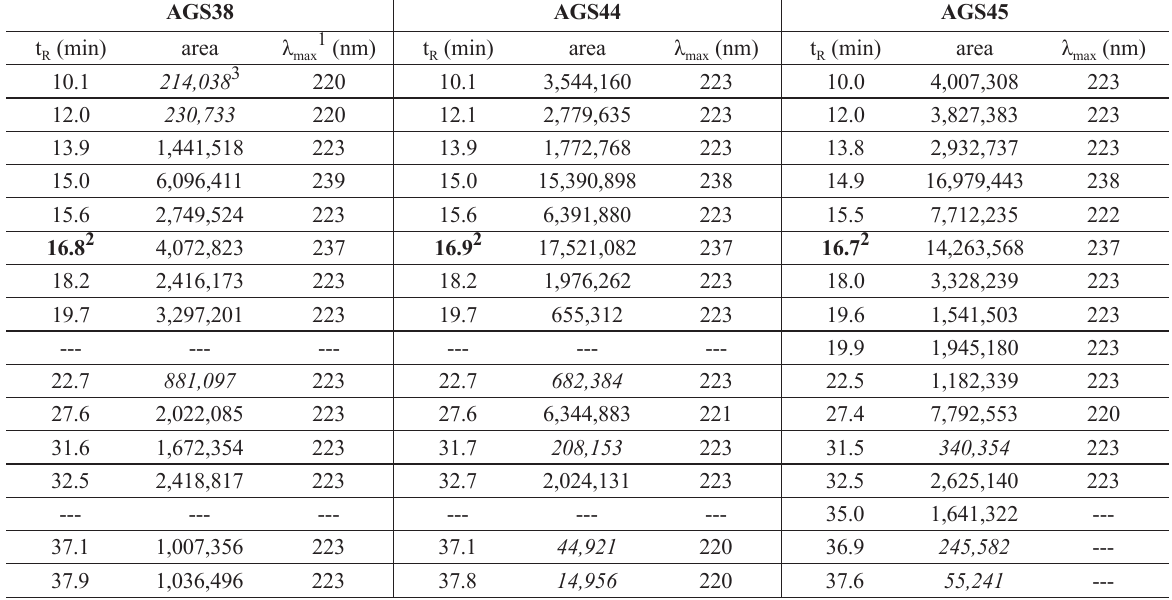
Data from HPLC-DAD analyses of specimens AGS38, AGS44 and AGS45. Retention time, area and λ of selected peaks (t > 10 min; area > 10 6 in at least one specimen of the group) are presented. R